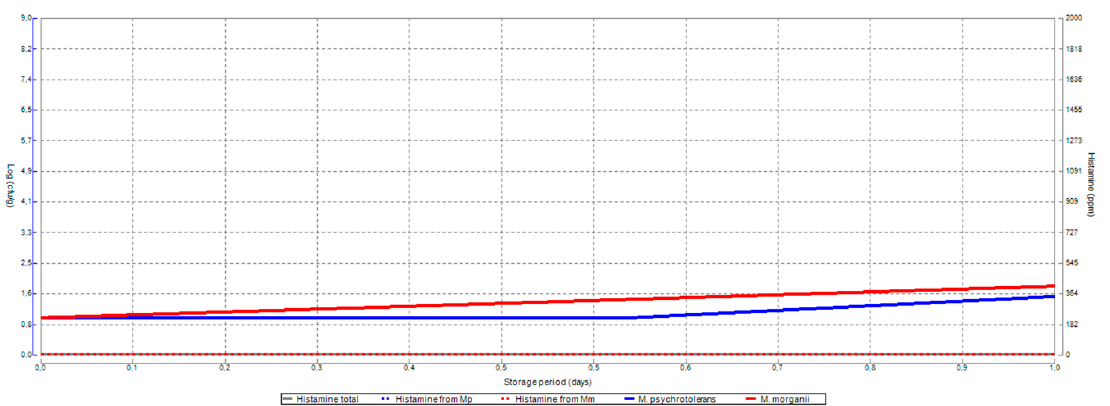
Figure 1. Application of Food Spoilage and Safety Predictor (FSSP) in the case of a good control of temperature.